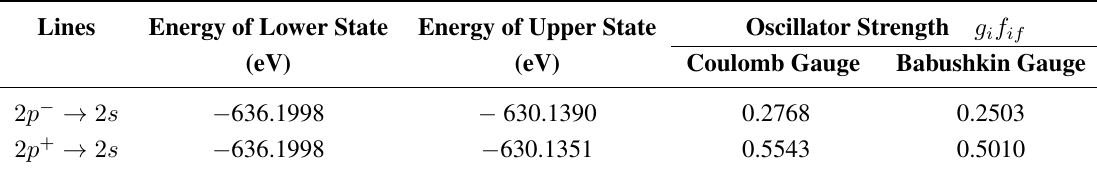
Table 1. The relative atomic structure data of B III 2p-2s lines are obtained by General Purpose Relativistic Atomic Structure Package (GRASP2)